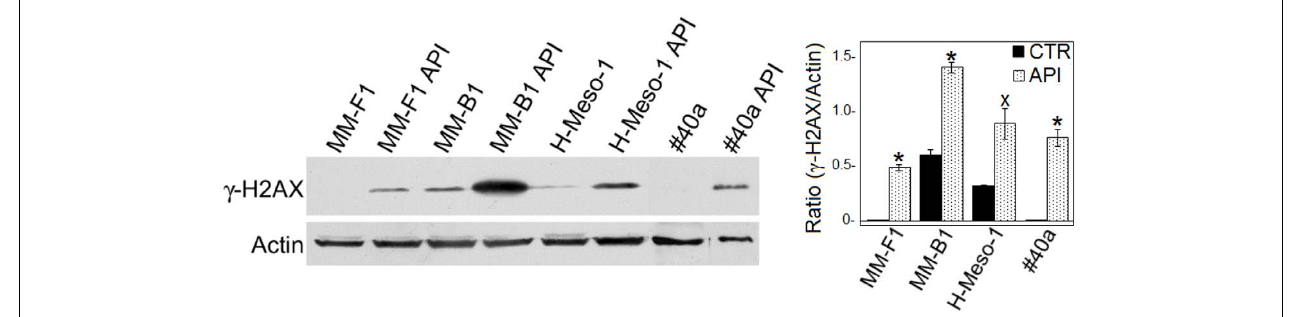
FIGURE 3 | Effect of API on DNA damage in MM cells. The expression of γ -H2AX was determined by Western blotting analysis in MM cell lines treated with API at 50 µ M or with DMSO (CTR) for 24 h. Actin was used as an internal control. The intensity of the bands was quantified using the ImageJ software after blot scanning of two independent experiments. The densitometric ratios between γ -H2AX and actin and statistical analysis are reported. Data are expressed as the mean ± SD of two independent experiments ( x p ≤ 0.05, ∗ p ≤ 0.01 compared with CTR).